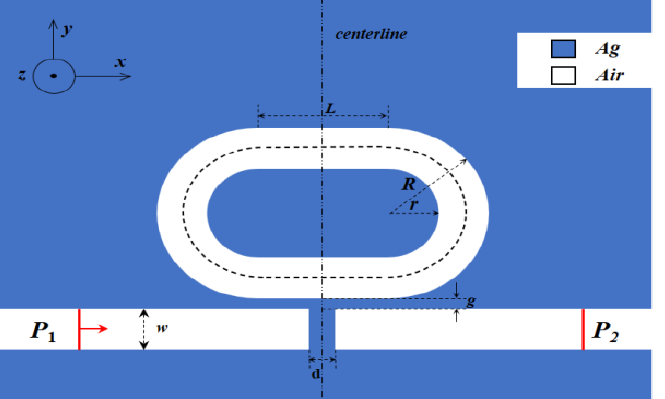
Figure 1. Schematic diagram of two-dimensional structure of plasmonic nanosensor.